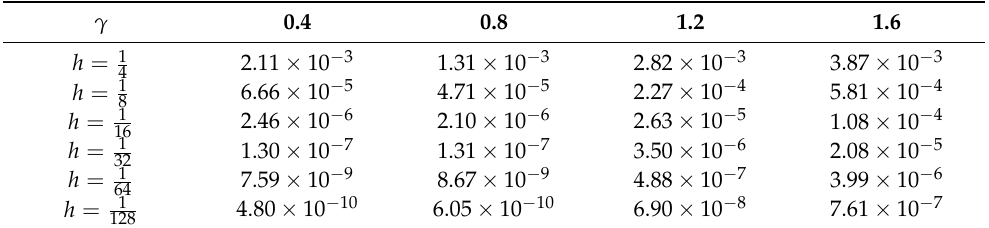
Figure 4. Example 3. Panel ( a ): The analytical solution (black line) and the numerical solution (red line) for h = 1 when ω = π , γ = 0.8. Panel ( b ): The analytical solution (black line) and the numerical 4 solution for h = 1 (magenta line) and h = 1 (red line) when ω = 5 π , γ = 1.2. Panels ( c , d ): The 8 128 local error e ( x ) for ( c ) ω = π and ( d ) ω = 5 π . Table 3. Example 3: The infinity norm of the error (cid:107) e h (cid:107) for different values of γ and h when ω = π .